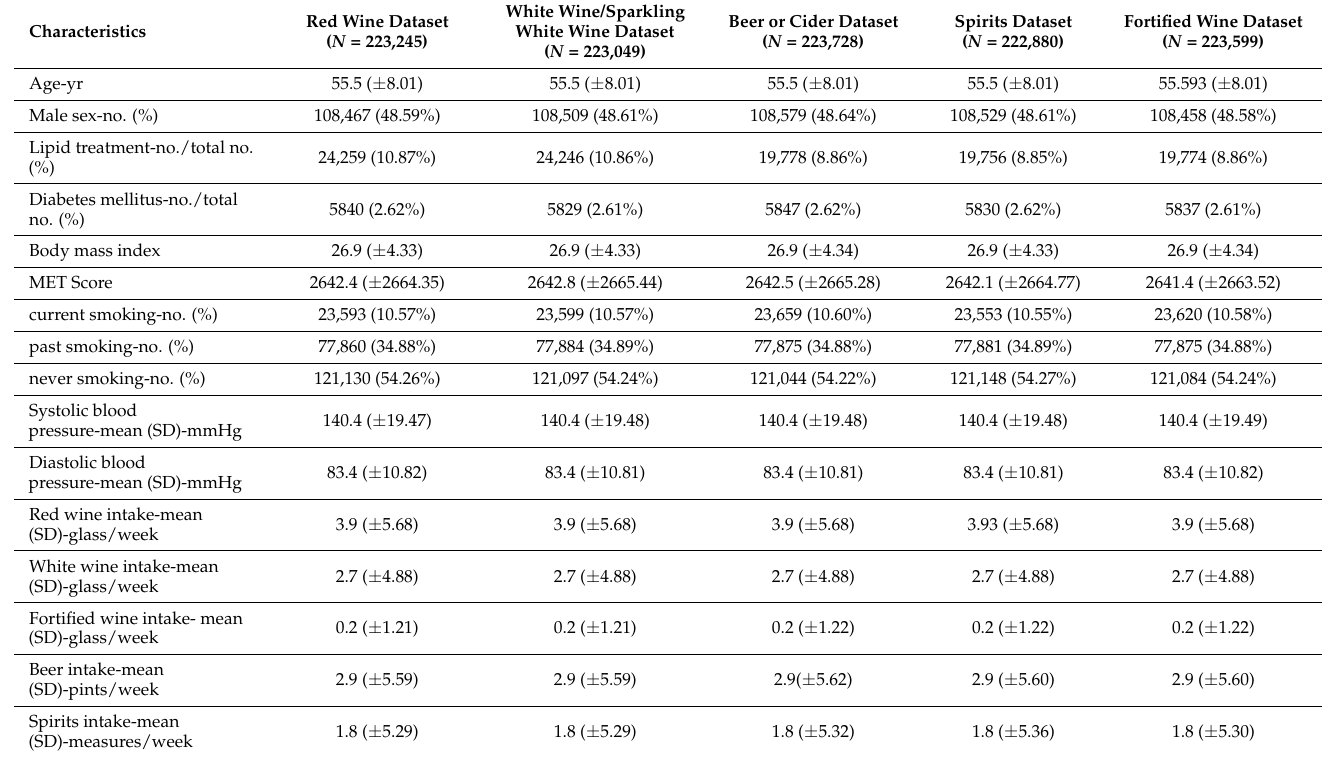
Table 1. Baseline characteristics of the population for